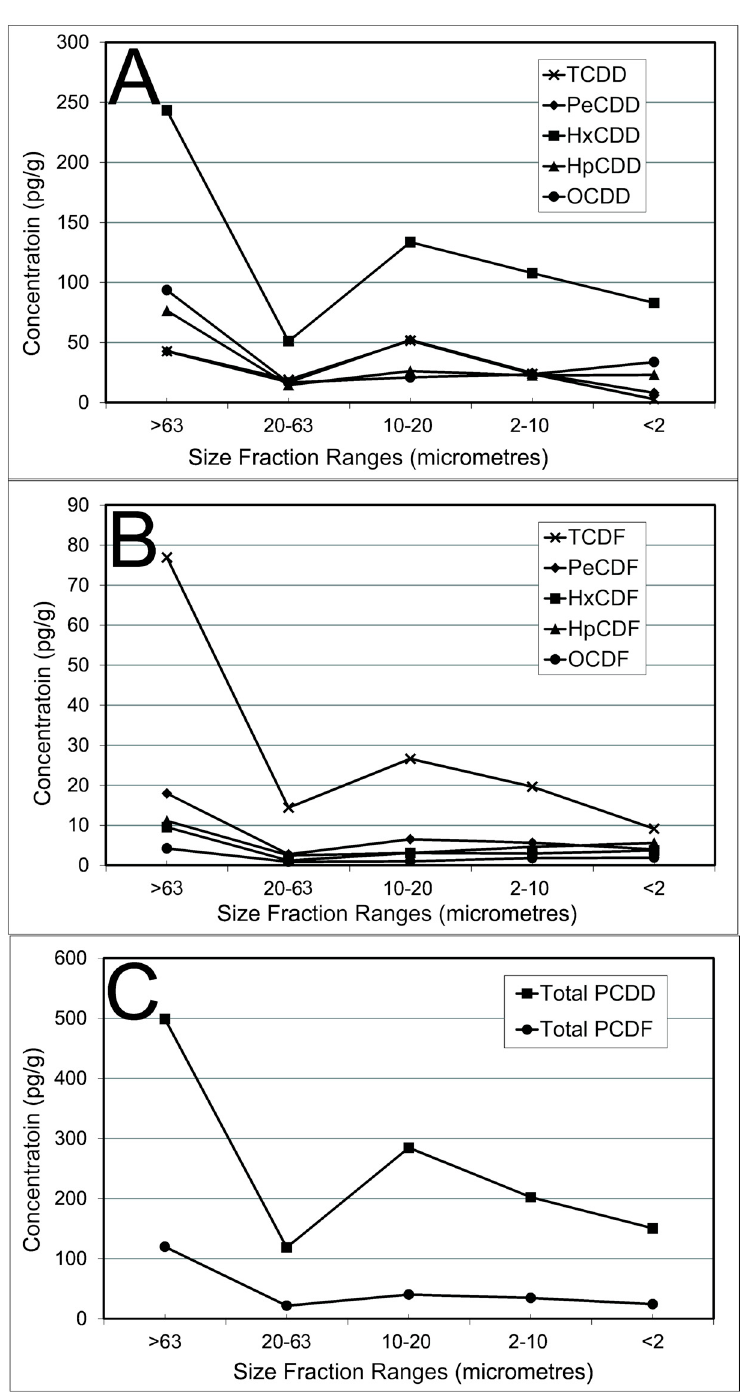
Figure 13. Plot showing the changes in concentration of dioxins ( A ), furans ( B ) and total homologues ( C ) between different size fractions at the 14–16cm depth interval. The overall trend is of decreasing concentration with progressively finer grain size.